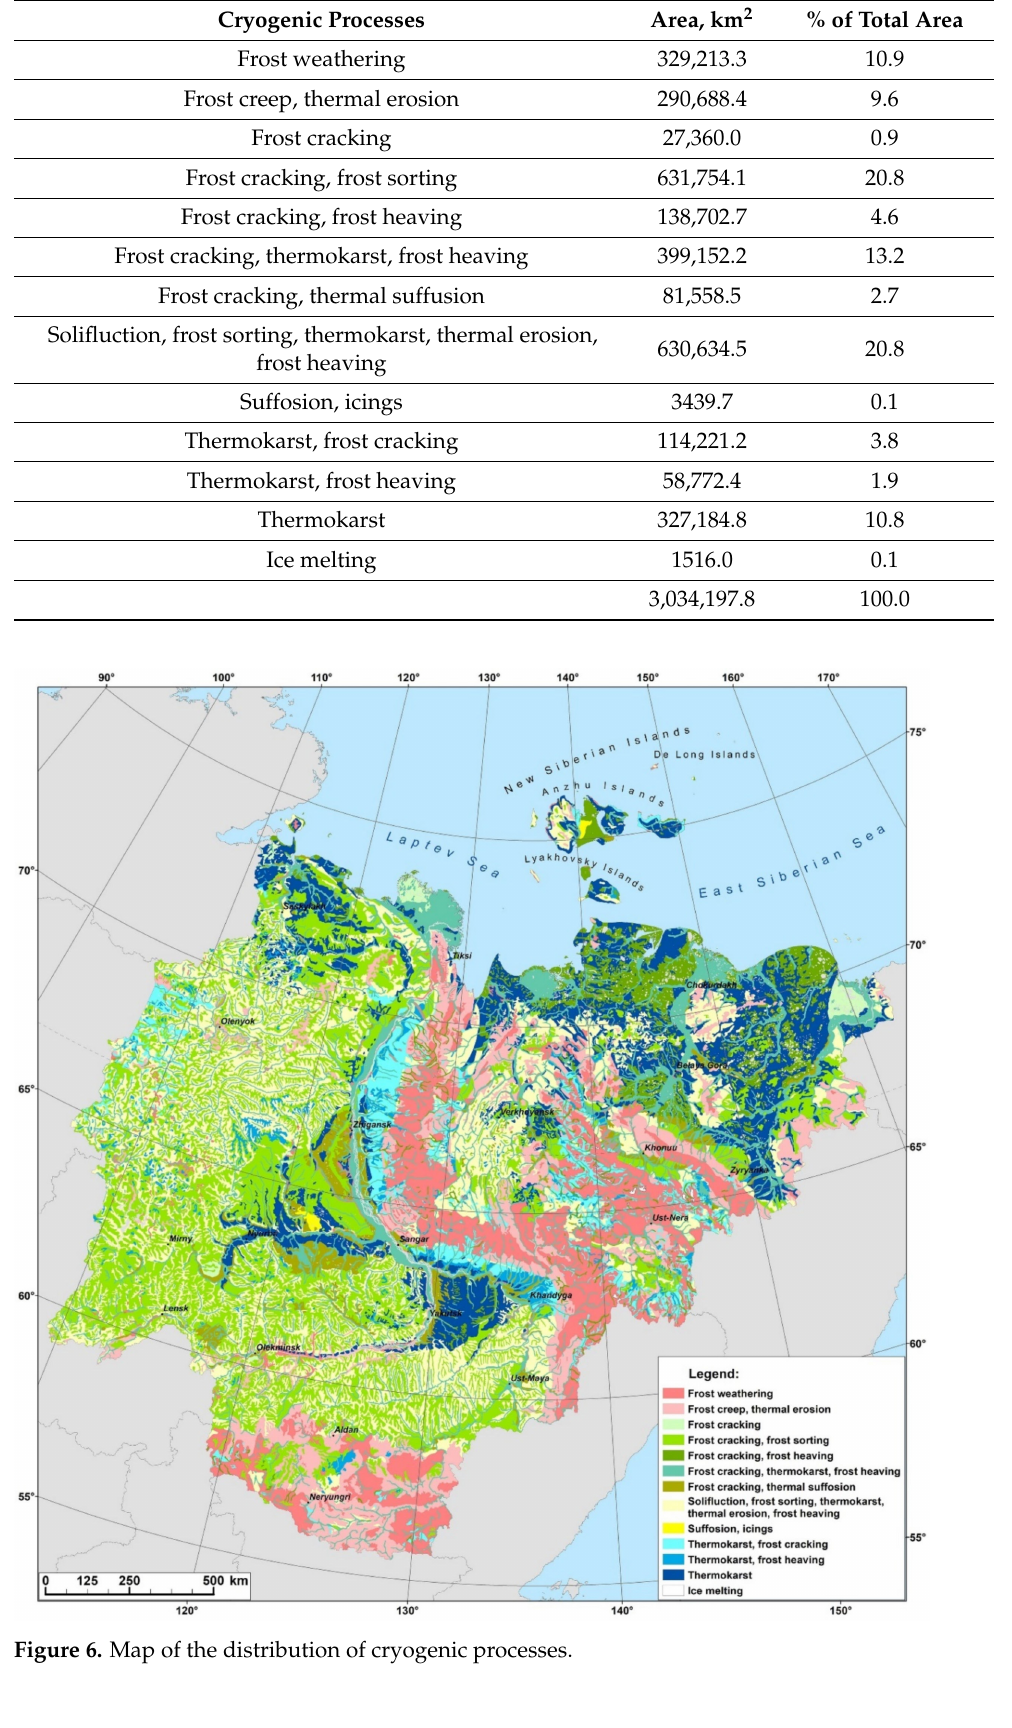
Table 4. Spatial distribution of cryogenic processes.